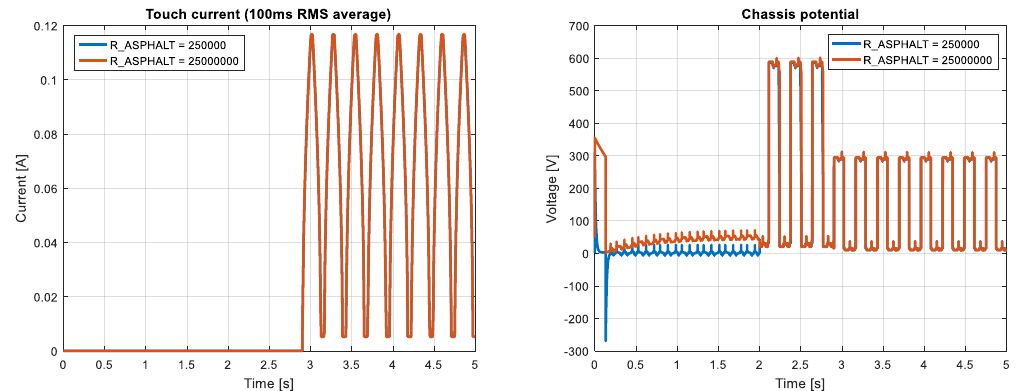
Figure 6. Touch current (100 ms RMS average) ( left ) and chassis potential ( right ) under pick-up to chassis insulation fault (at t = 2s) and touch event (at t =